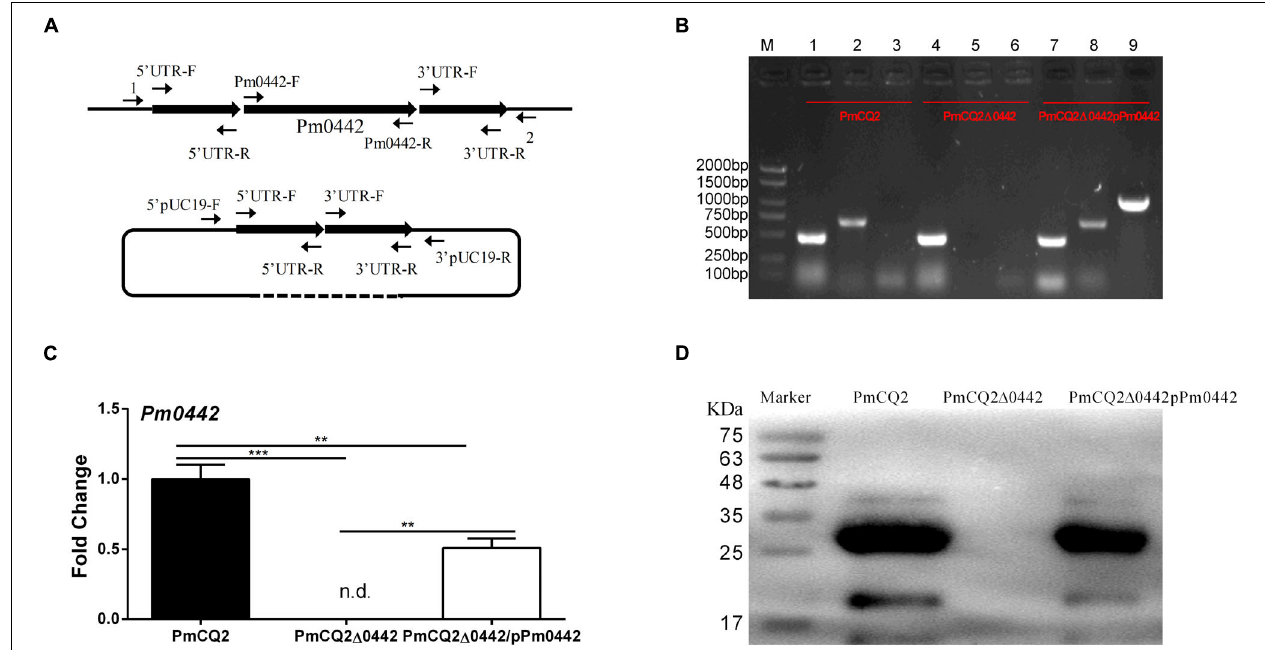
FIGURE 1 | PmCQ2 (cid:49) 0442 mutant construction. (A) Schematic to delete Pm0442 gene by single-crossover recombination. (B) PCR confirmation of mutant and complementation strains. M: DNA marker; Lanes 1–3: PmCQ2; Lanes 4–6: PmCQ2 (cid:49) 0442; Lanes 7–9: PmCQ2 (cid:49) 0442/pPm0442. Lanes 1, 4, and 7: KMT1-F and KMT1-R (positive control); lanes 2, 5, and 8: Pm0442-F and Pm0442-R; Lanes 3, 6, and 9: Pm0442-F and pUC19-R. (C,D) Pm0442 transcription and expression of were measured using qRT-PCR (C) and western blotting (D) . Panels (B,D) were pooled from three independent experiments. Panel (C) were pooled from three independent experiments with 6 replicates per group, and were analyzed by multiple comparative analysis, and expressed as means ± SD. ** P < 0.01, *** P <